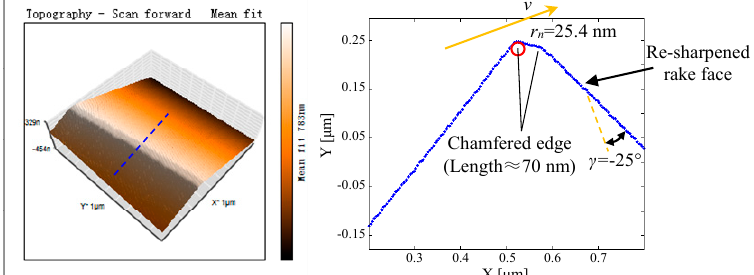
Figure 14. Measured result of the chamfered cutting edge after the passivation at the depression angle of 60° and the re-sharpening of rake face ( v represents the tool cutting velocity).